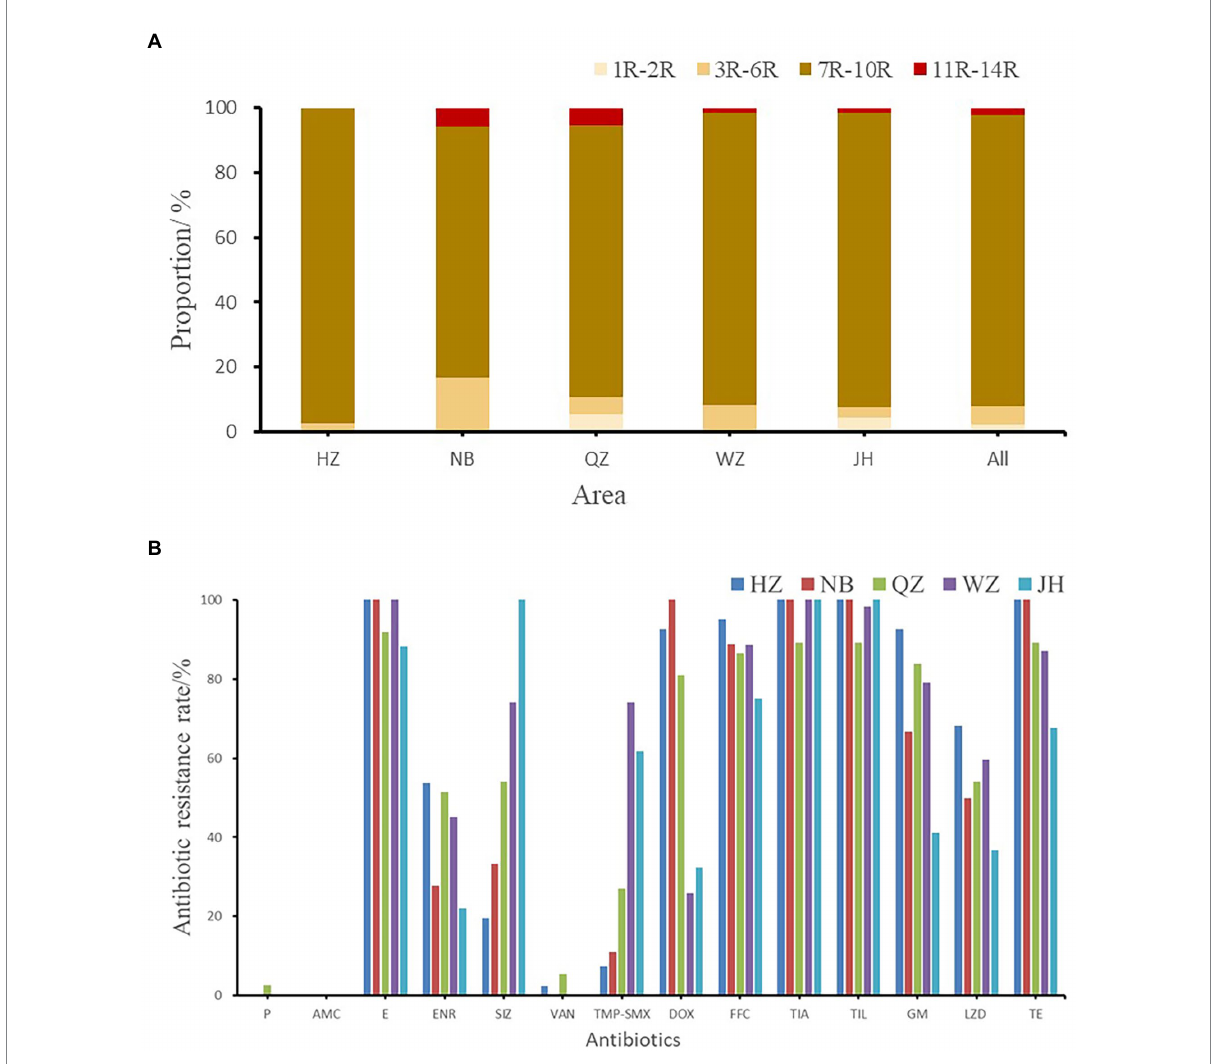
FIGURE 2 (A) The multi-drug resistance of Enterococcus faecalis from swine in Zhejiang. (B) The resistance rate of E. faecalis from five cities. HZ, Hangzhou; NB, Ningbo; QZ, Quzhou; WZ, Wenzhou; JH, Jinhua; All, Zhejiang